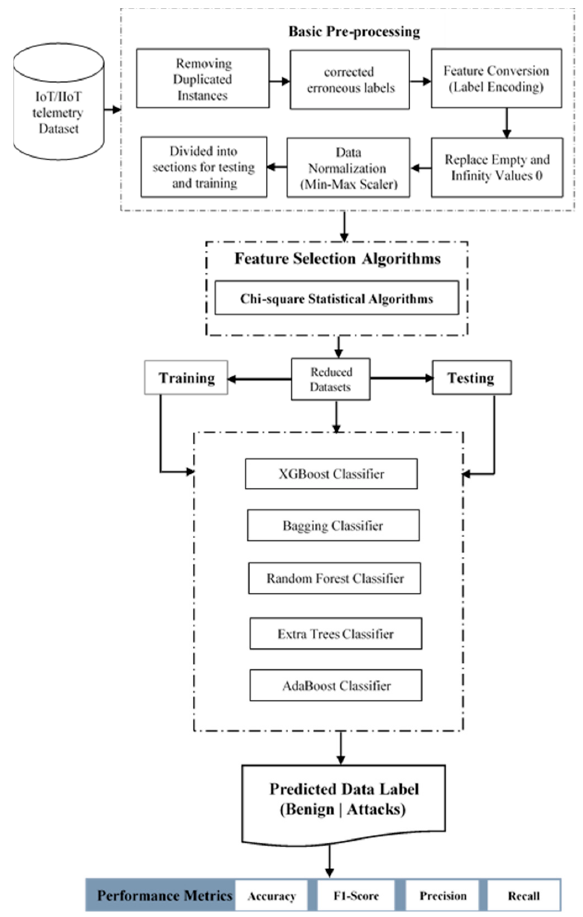
Figure 1. The proposed workflow for the classification of cyberattacks in an IoT network.